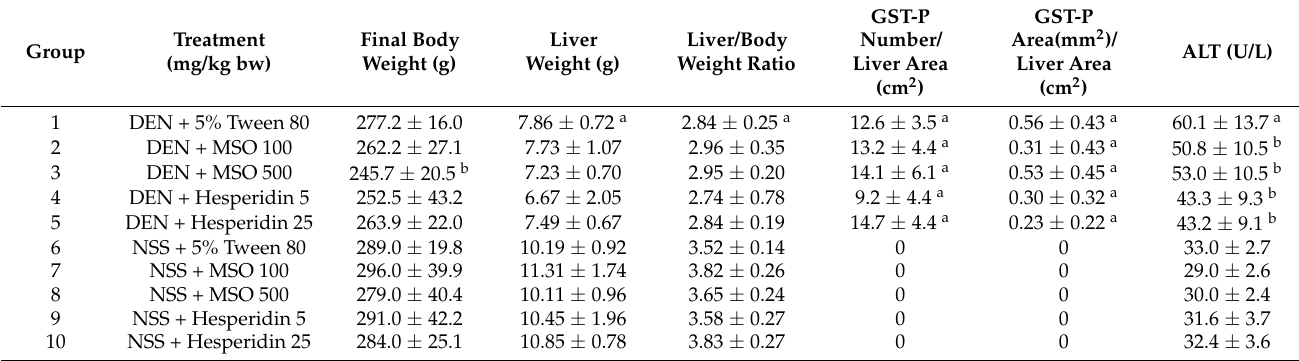
Table 1. Effect of a 5-week administration of MSO and its compositions on liver weight, serum ALT level and GST-P-positive foci formation in rats.